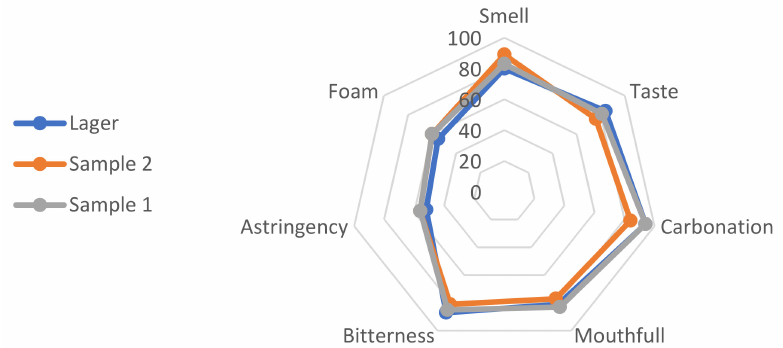
Figure 1. Sensory analysis of samples (all values are a result of triplicate analysis); sample 1 is fermented at 21 ◦ C; sample 2 is fermented at 35 ◦ C.